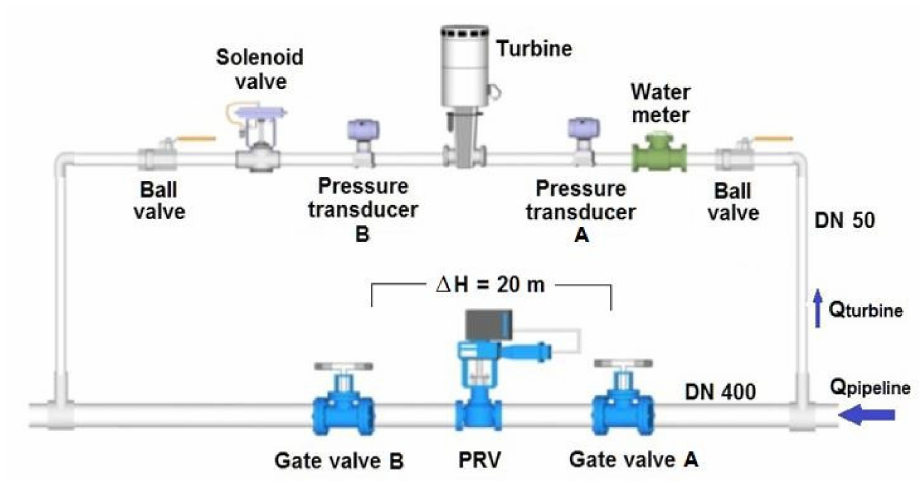
Figure 3. Schematic of the ERT bypass installed on the existing PRV.